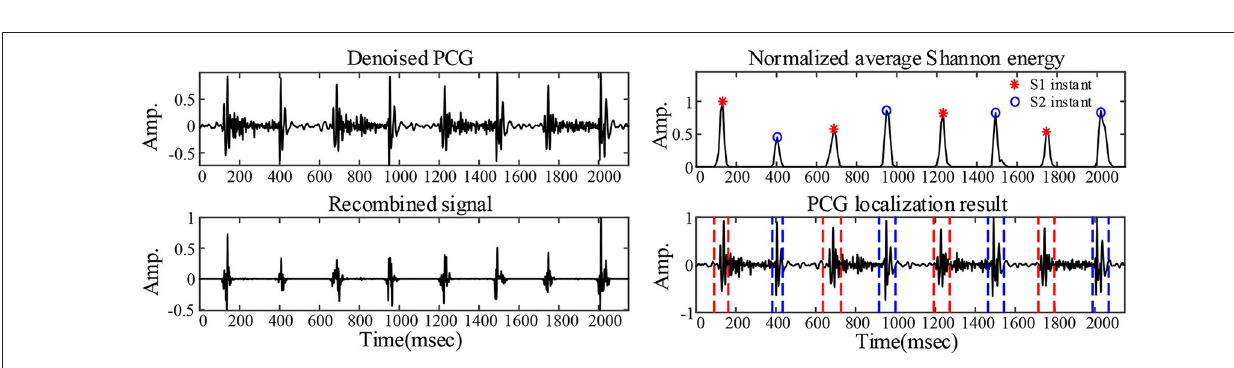
FIGURE 6 | Comparison of Mel filter energies after noise reductions for PCG with severe crying noise.